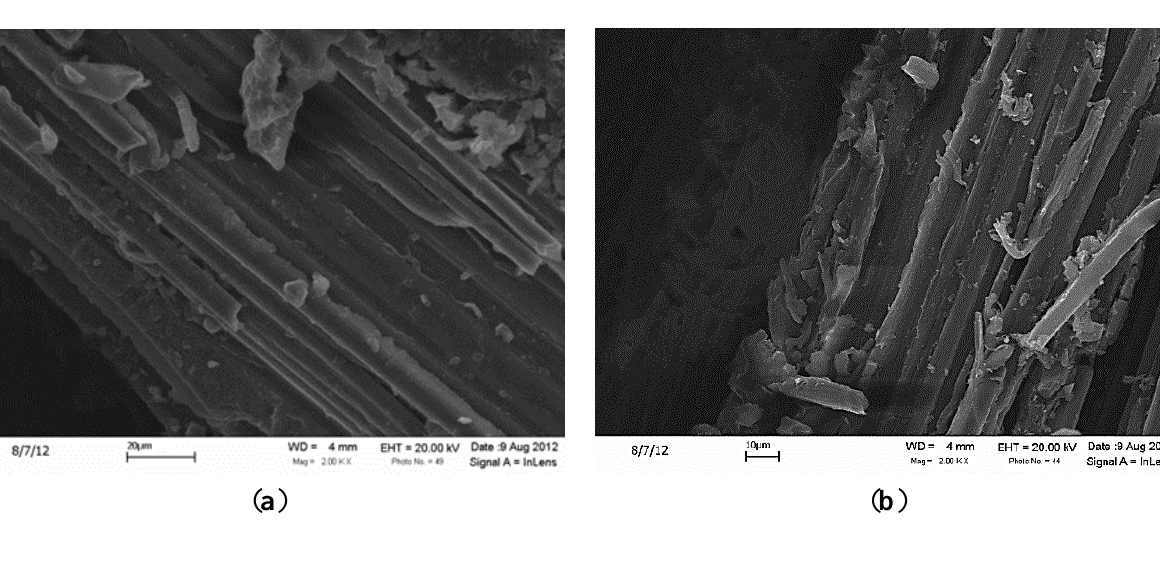
Figure 6. Polymer matrix penetration of the region adjacent to the nanofilaments for the composites based on the ( a ) CCVD and ( b ) GSD